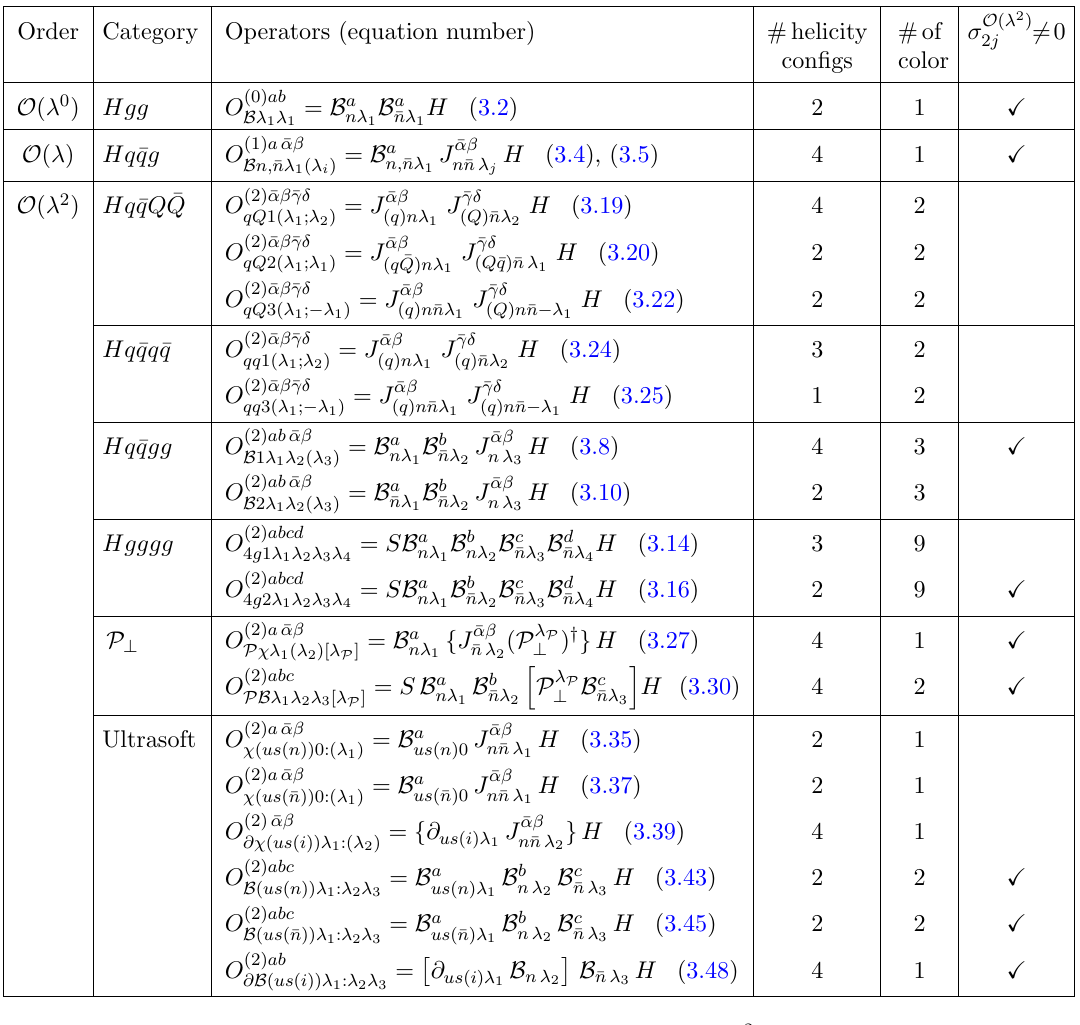
Table 3 . Basis of hard scattering operators for gg ! H up to O ( (cid:21) 2 ). The (cid:21) i denote helicities, S represents a symmetry factor present for some cases, and detailed lists of operators can be found in the indicated equation. The number of allowed helicity con(cid:12)gurations are summarized in the fourth column. The (cid:12)nal column indicates which operators contribute to the cross section up to O ( (cid:21) 2 ) in the power expansion, as discussed in section 3.4. Counting the helicity con(cid:12)gurations there are a total of 53 operators, of which only 28 contribute to the cross section at O ( (cid:21) 2 ). Of those 28, only 24 have non zero Wilson coe(cid:14)cients at tree level since the operators in eq. (3.27) are absent at this order. These numbers do not include the number of distinct color con(cid:12)gurations which are indicated in the 5th